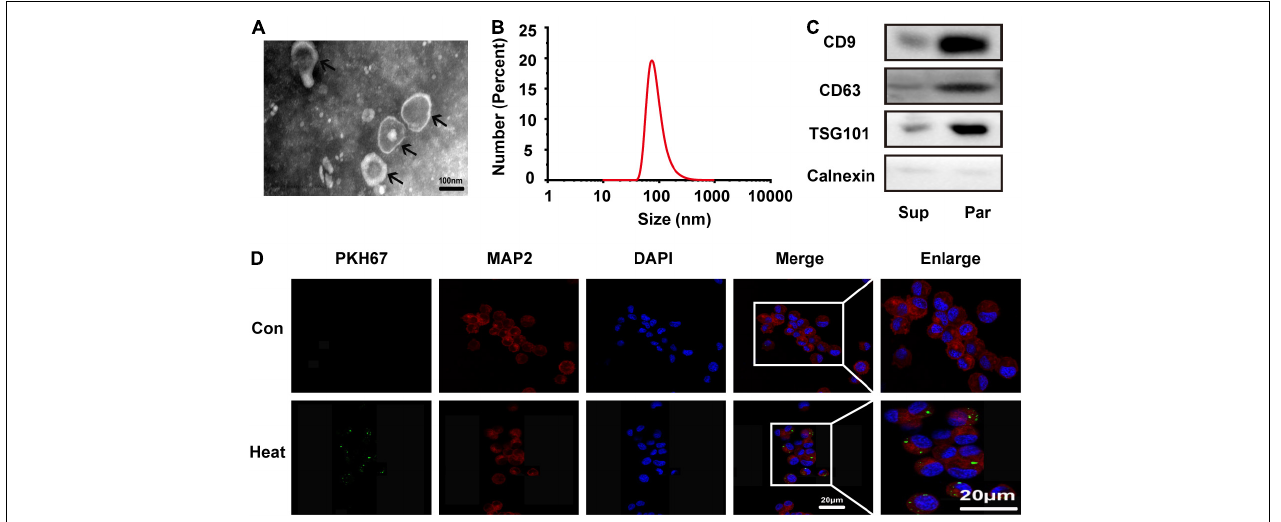
FIGURE 2 | Microglia-derived exosomes were characterized and taken up by N2a cells. Exosomes were extracted from microglial culture supernatant by ultracentrifugation. (A) Morphology was observed by transmission electron microscopy (TEM). (B) The size distribution was measured by a Nanozsp tracking analyzer. (C) Biomarkers of exosomes, including CD9, CD63, TSG101, and Calnexin, were analyzed by Western blotting. (D) N2a cells were co-incubated with or without PKH67-labeled microglial exosomes (50 µ g/ml) for 24 h, the cells were then stained with anti-MAP2 and DAPI, and microglial exosome uptake was detected via confocal microscopy. Representative and enlarged images are shown. Sup refers to microglial supernatant, Par refers to microglia-generated